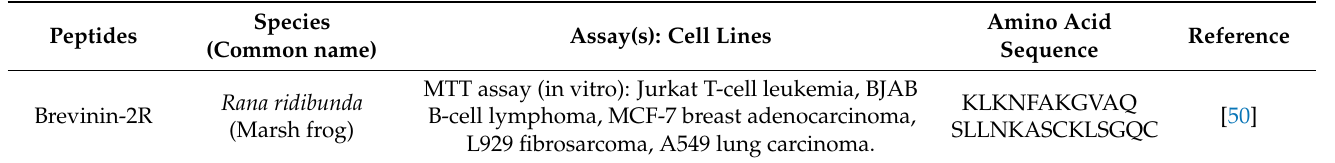
Table 4. Representative anticancer peptides (ACPs) isolated from various species of